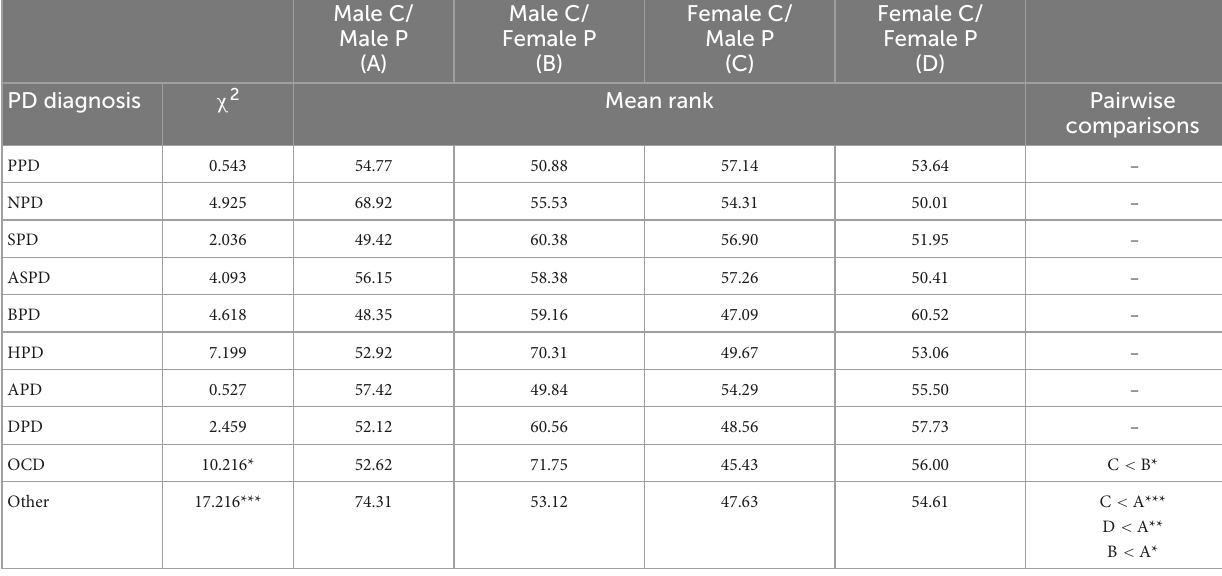
TABLE 4 Clinicians’ gender bias in diagnoses for cases with vulnerable narcissism